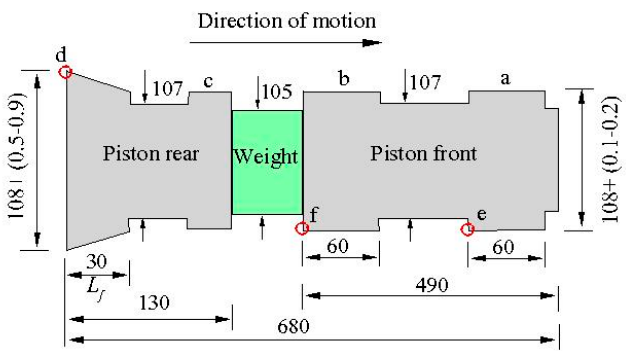
Figure 2. Schematic diagram of the piston (not to scale, units in mm).